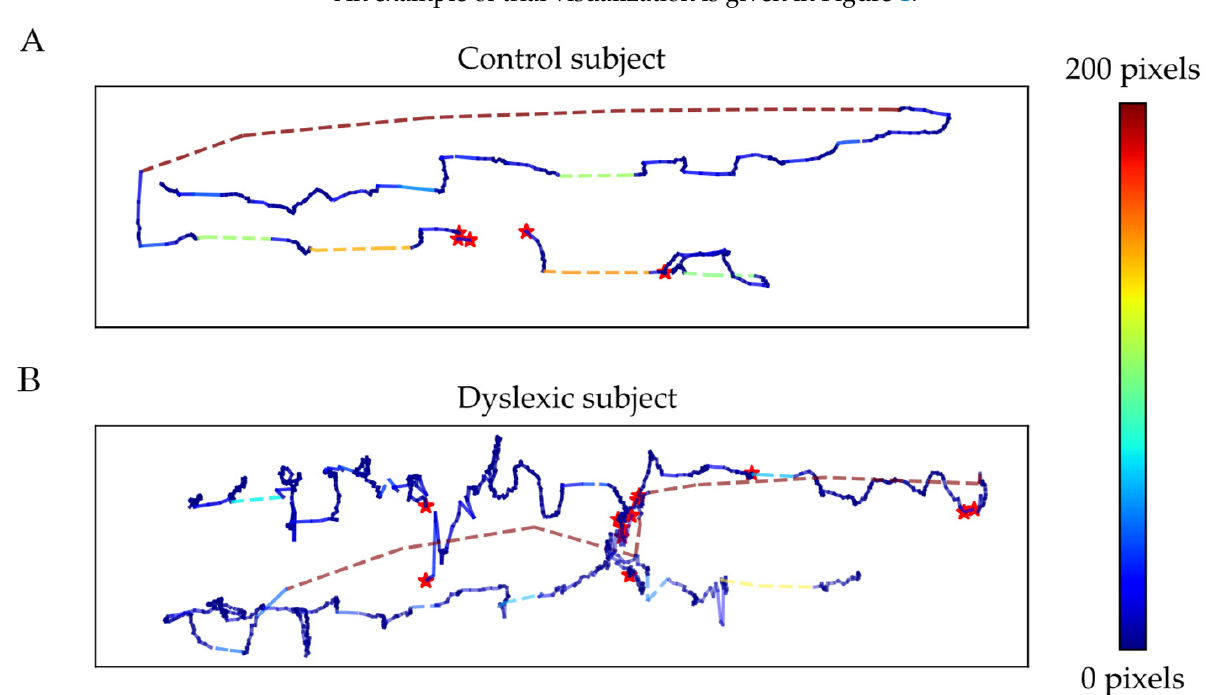
Figure 1. Trial visualization example for ( A ) a control subject and ( B ) a dyslexic subject. The color of the line represents the line length in pixels according to the presented color scale and the red stars represent blink events.